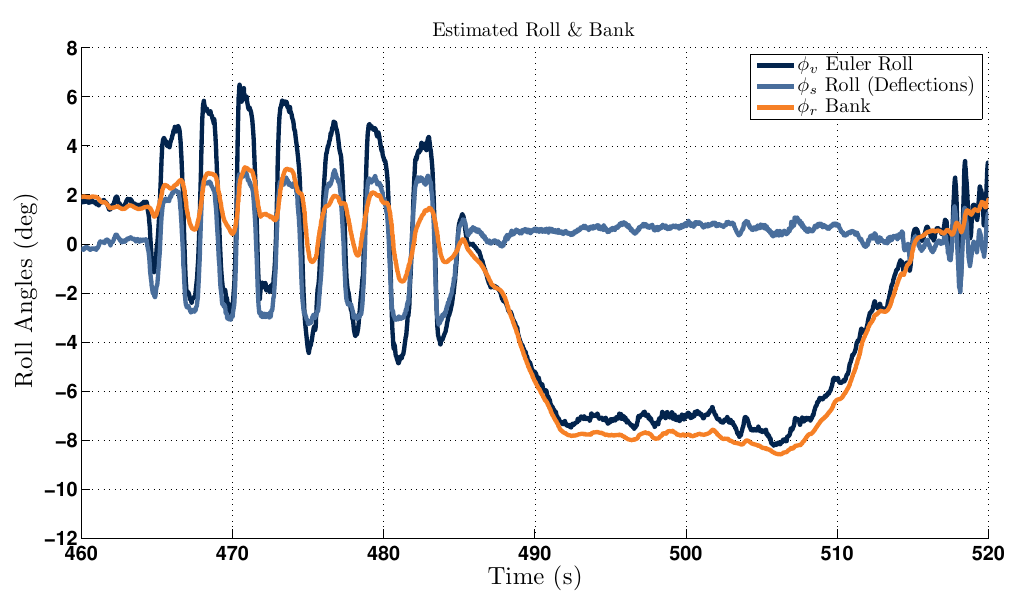
Figure 14. Bank estimate on the NCAT oval track 16-state coupled